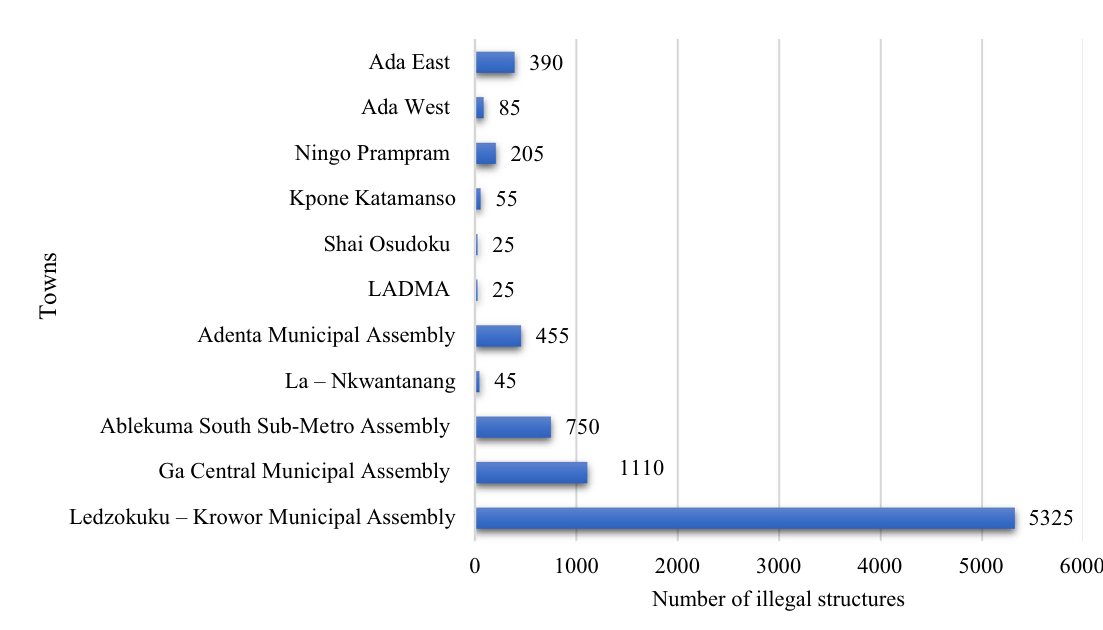
Fig. 5 Geology map